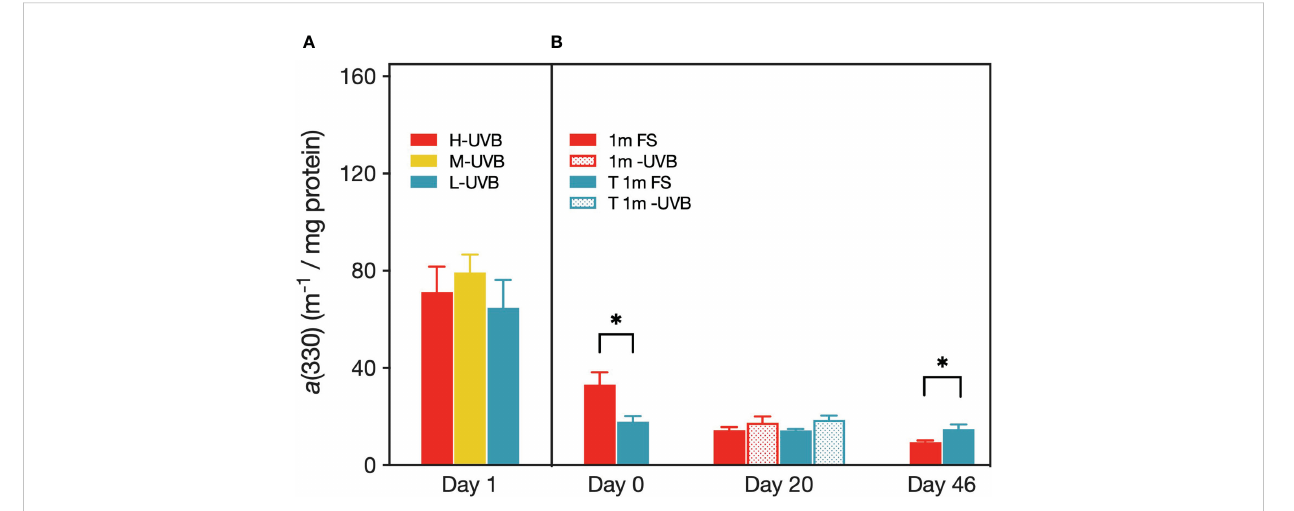
FIGURE 9 Absorption coef fi cient at 330 nm (m -1 per mg protein) of coral host tissue from Stylophora pistillata (A) and Pocillopora verrucosa (B) . Values are means (n=5) ± SEM. Asterisks indicate cases where the Tukey ’ s post hoc test identi fi ed signi fi cantly different means between treatments at a level of p <